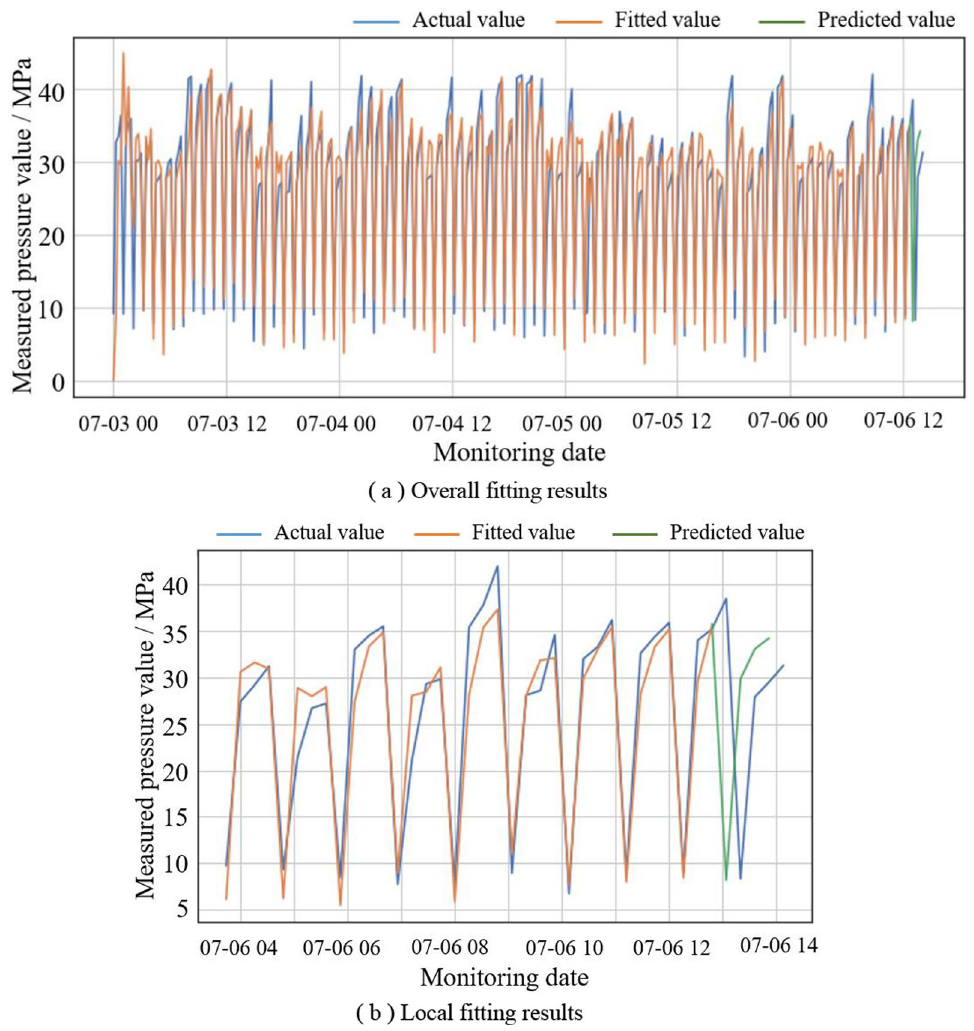
Fig. 12 SARIMA model fitting